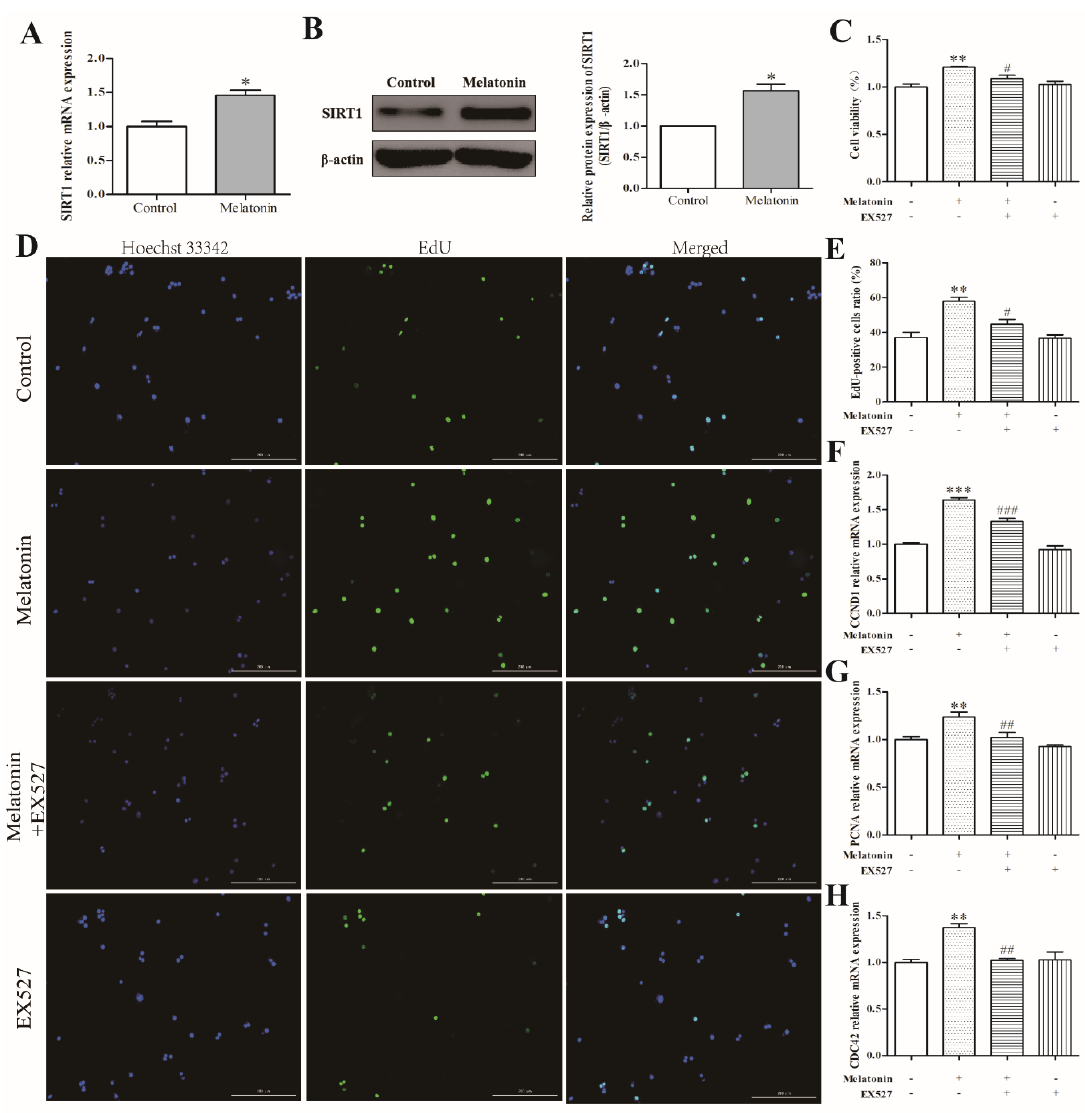
Figure 4. E ff ects of melatonin and EX527 on cell viability and proliferation related genes of mouse Leydig cells. ( A ) The mRNA expression level of SIRT1 ( n = 3). ( B ) The protein expression level of SIRT1 ( n = 3). ( C ) The e ff ects of melatonin and EX527 on cell viability of mouse Leydig cells ( n = 3). ( D ) Proliferation of mouse Leydig cells in the control, melatonin, melatonin + EX527, and EX527 groups was measured using the EdU incorporation assay. Green fluorescence represents EdU-labeled Leydig cells (original magnification × 10). ( E ) The proportion of EdU-positive Leydig cells as shown in panel ( D ). The e ff ects of melatonin and EX527 on mRNA expression levels of CCND1 ( F ), PCNA ( G ), and CDC42 ( H ) in mouse Leydig cells ( n = 3). Values are shown as mean ± SEM. *** p < 0.001, ** p < 0.01 or * p < 0.05 compared with the control group; ### p < 0.001, ## p < 0.01 or # p < 0.05 compared with the melatonin-only treatment group.